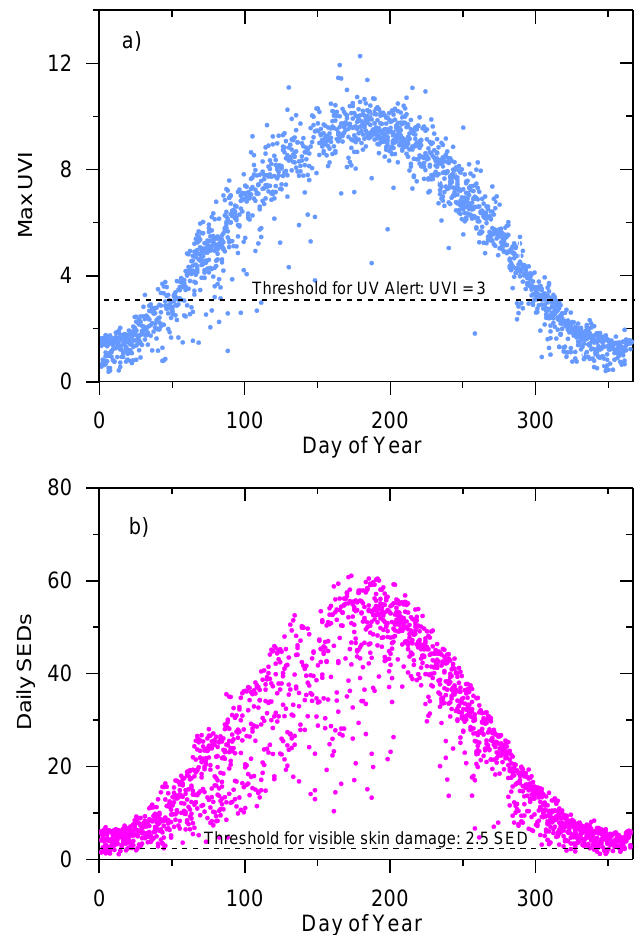
Figure 6. ( a ) Experimental yearly evolution of maximum daily UVI ( b ) and daily dose in SEDs, measured in Valladolid, Spain.